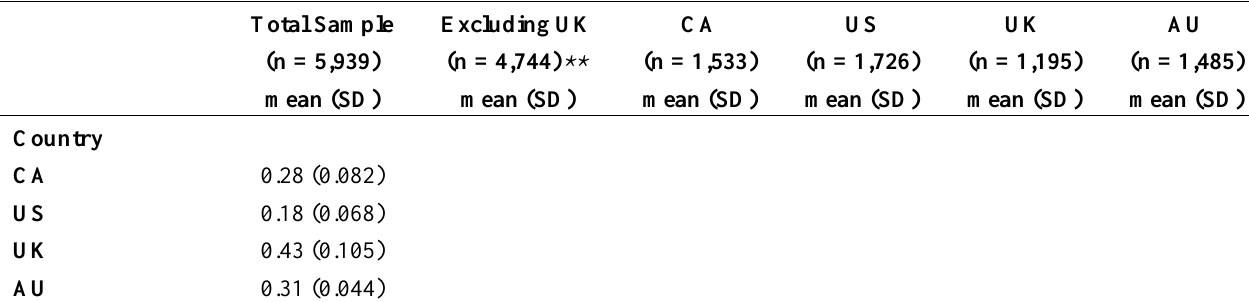
Table 5. Price per cigarette overall and by country for various price and tax avoidance techniques at last purchase (excluding RYO users *) and for a sub-sample that excludes UK